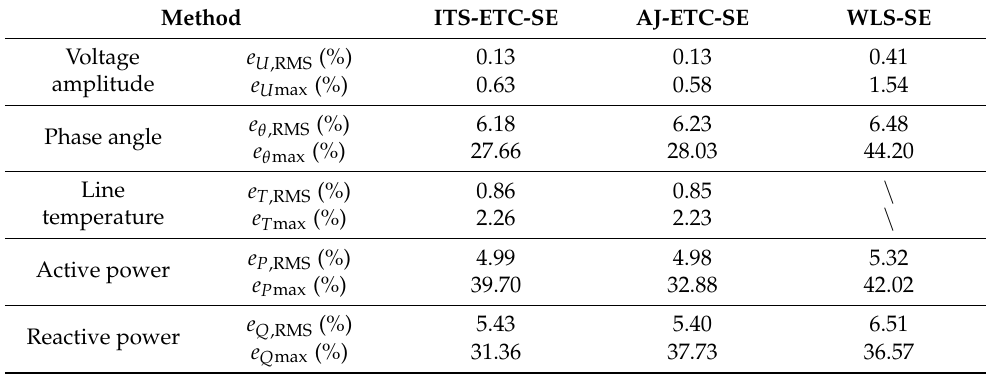
Table 2. Estimated errors with different methods.